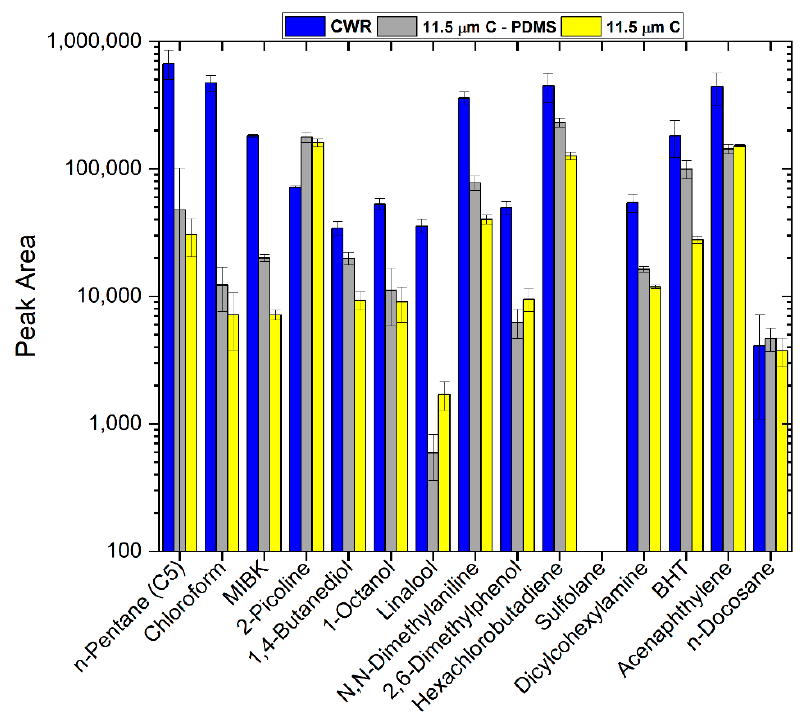
Figure 5. Comparison of DI – SPME – GC – MS results for 11.5 µm sputtered carbon SPME fibers and the commercial CWR SPME fiber. n = 3 for each compound, and y-error bars represent standard deviations.